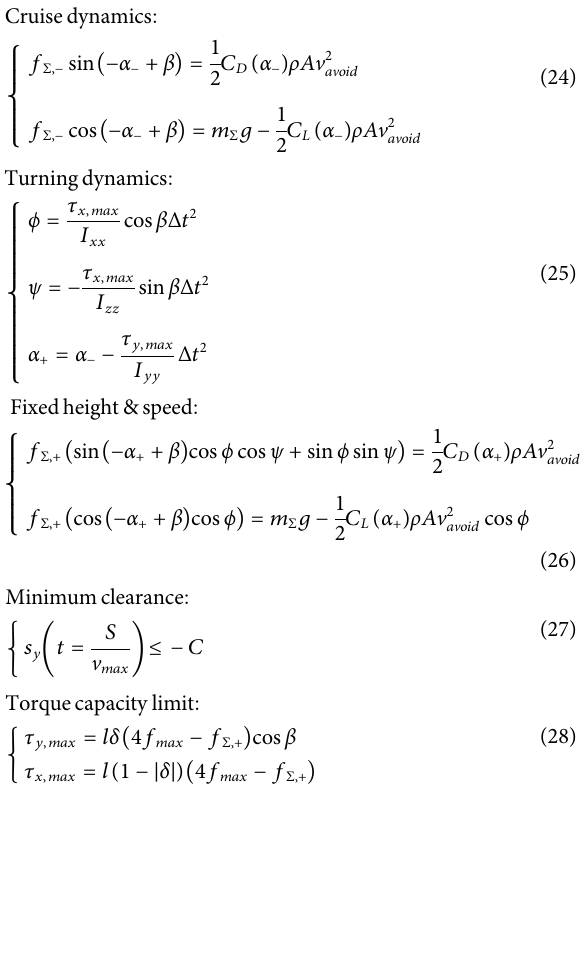
Figure 8 shows the example obstacle avoidance maneuver. The maximum crash-free cruise speed v avoid thus re fl ects the high-speed agility of the vehicle. The faster a vehicle can travel without having to crash into the obstacle, the more agile it is. The correlation between v avoid and β can be solved by maximizing